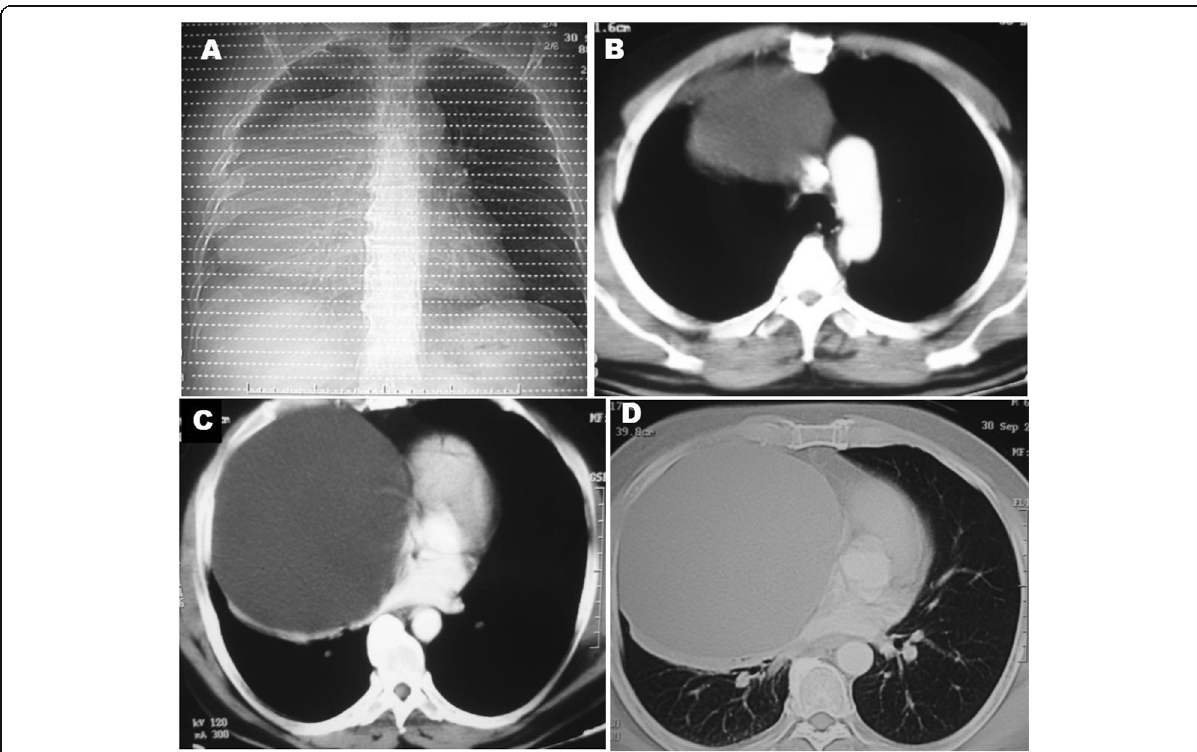
Fig. 2 Sixty-year-old male patient complaining of dyspnea. a Reconstruction image showing right-sided opacity not silhouetting the cardiac border. b – d Contrast-enhanced axial CT chest mediastinal and lung windows showing anterior mediastinal fluid attenuating non-enhancing cystic lesion. It shows a thin rim with no enhancement. CT diagnosis and histopathological confirmation revealed “ thymic cyst